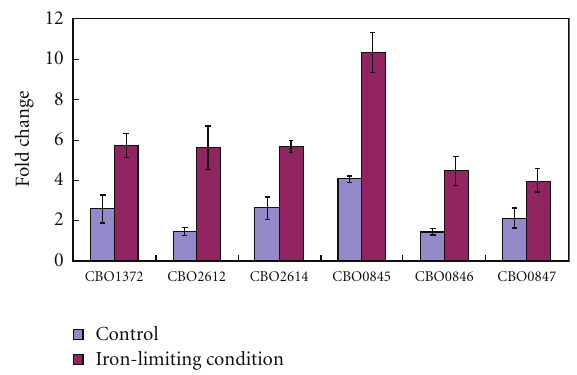
Figure 2: The di ff erentially expressed genes under the iron- limitation condition in Clostridium botulinum A ATCC